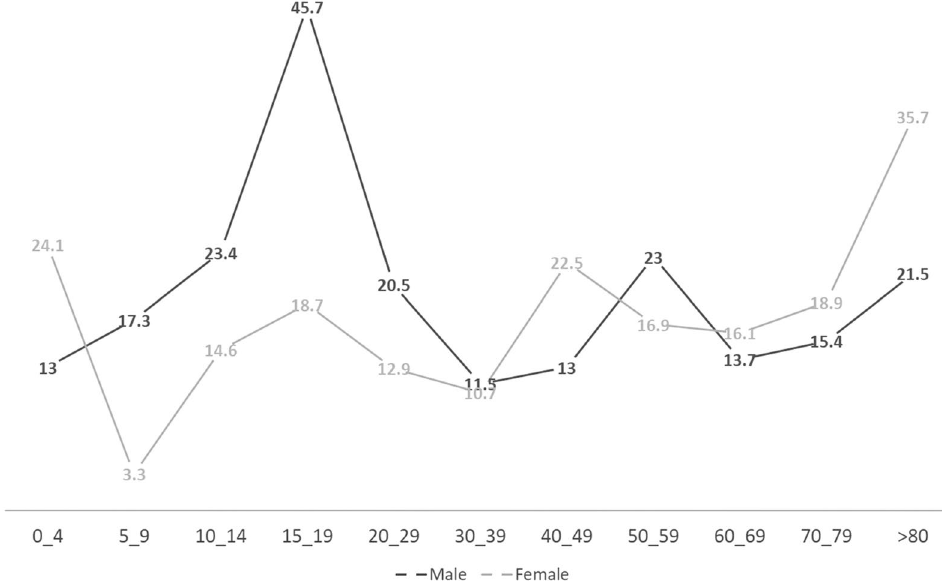
Figure 1. The life time prevalence of epilepsy in age and sex groups.